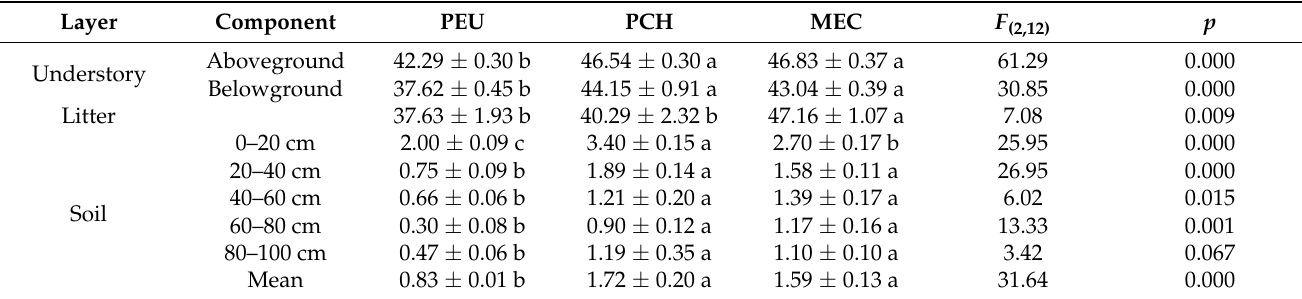
Table 6. Carbon content (%) in the understory vegetation, litter, and soil layers.